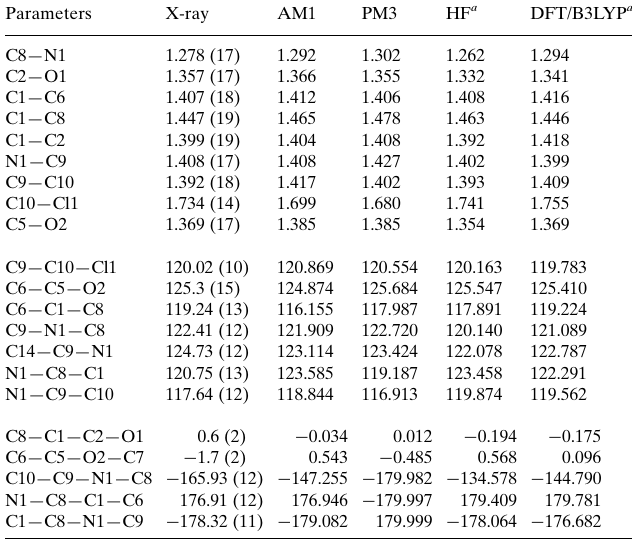
Selected geometric parameters (A˚ , (cid:1) ) calculated with X-ray, AM1, PM3, HF and DFT.